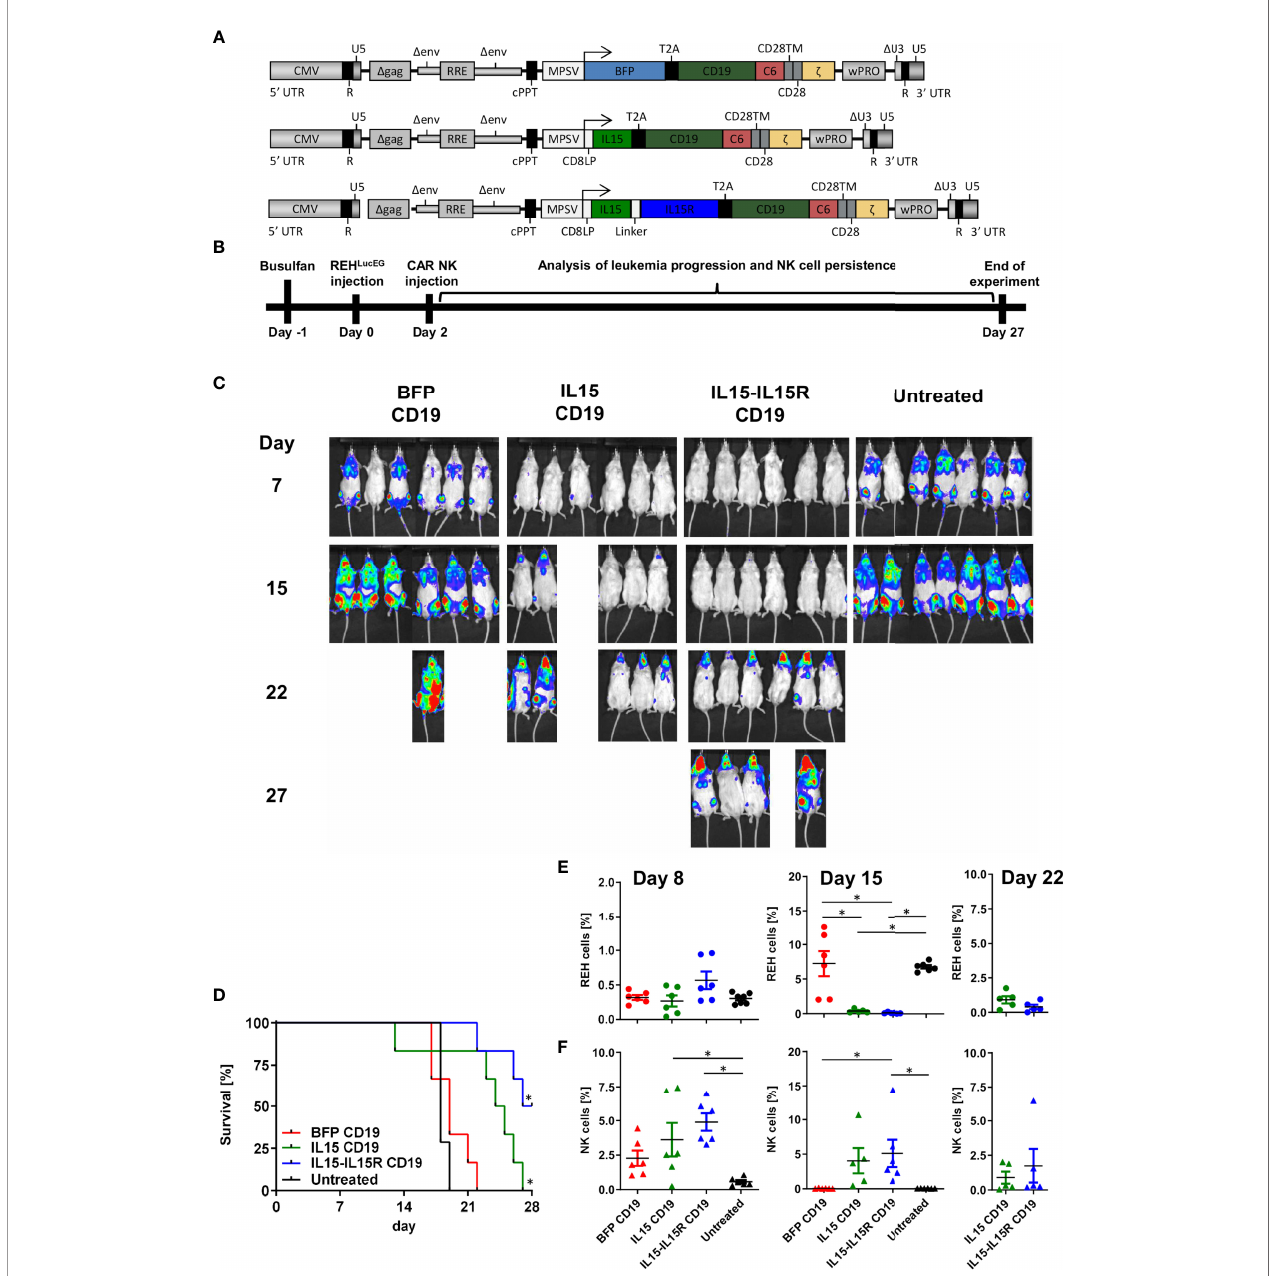
FIGURE 7 | CAR NK cells rely on endogenous IL15 production for leukemia control in an ALL xenograft model. (A) Schematic representation of vector maps of CAR constructs used for NK cell transduction. (B) Primary human NK cell preparations consisting of 50% BFP/CD19 CAR, IL15/CD19 CAR, or IL15-IL15R/CD19 CAR and 50% non-transduced NK cells were injected 2 days after xenotransplantation of REH LucEG into busulfan-preconditioned NSG mice (6 animals per group, 7 animals as untreated control). (C) On days 7, 15, 22, and 27, leukemia progression was analyzed by luminescence imaging in a Caliper device. (D) Kaplan – Meier survival curves for the three treatment groups and the untreated control animals. (E) REH LucEG and (F) NK cell persistence in the bloodstream was analyzed by CD19, CD34, CD45, and CD56 staining as well as EGFP expression by fl ow cytometry. Data are represented as mean ± SEM. Signi fi cances of p<0.05 are indicated by an asterisk